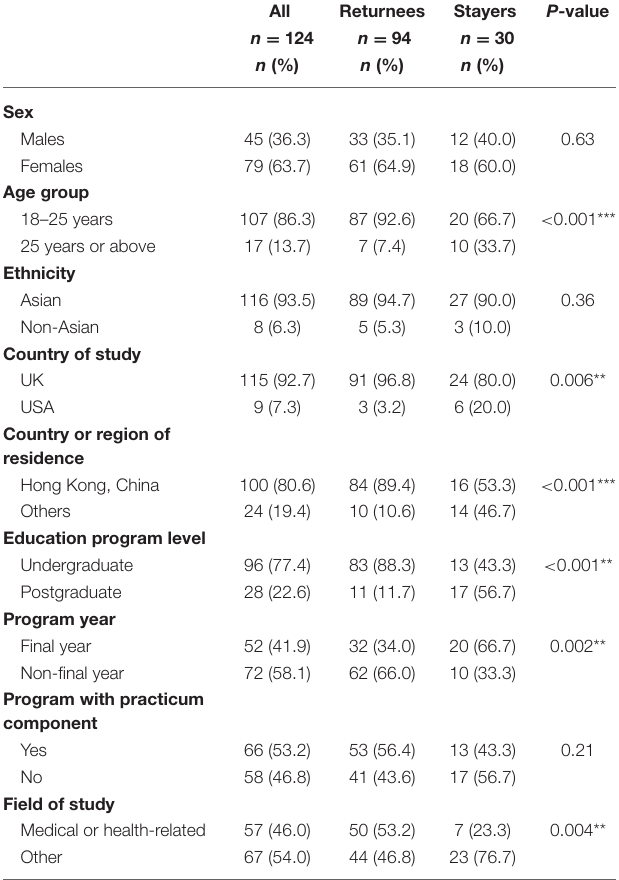
TABLE 1 | Characteristics of international students in the UK and USA who returned to their home country or region (returnees) and those who stayed in their institution country